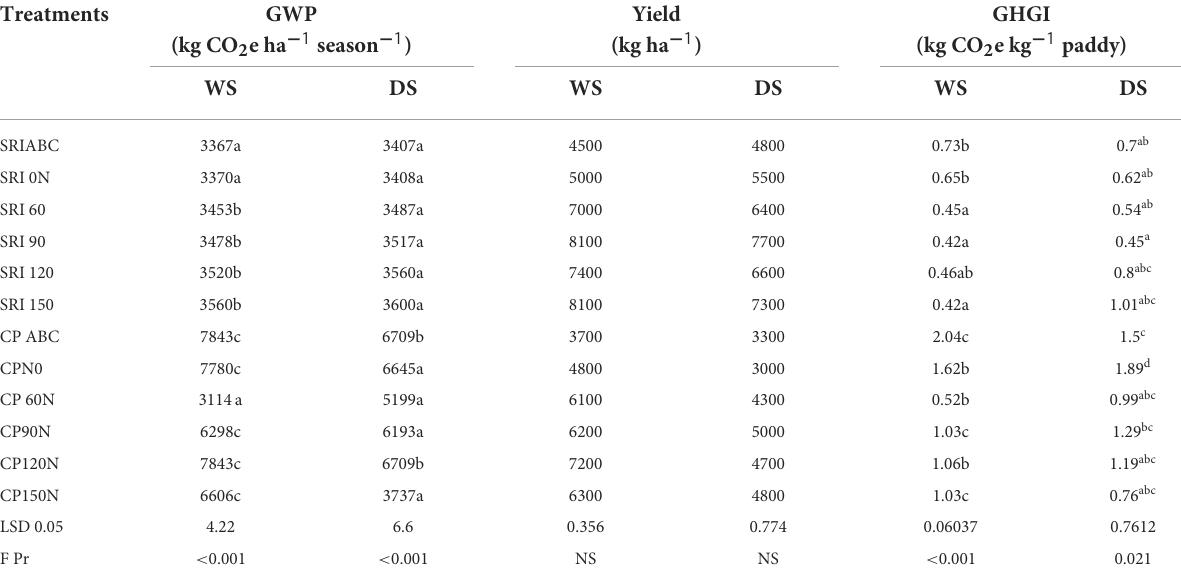
TABLE 11 Global warming potential, grain yield and greenhouse gas intensity as affected by management practices and nitrogen.